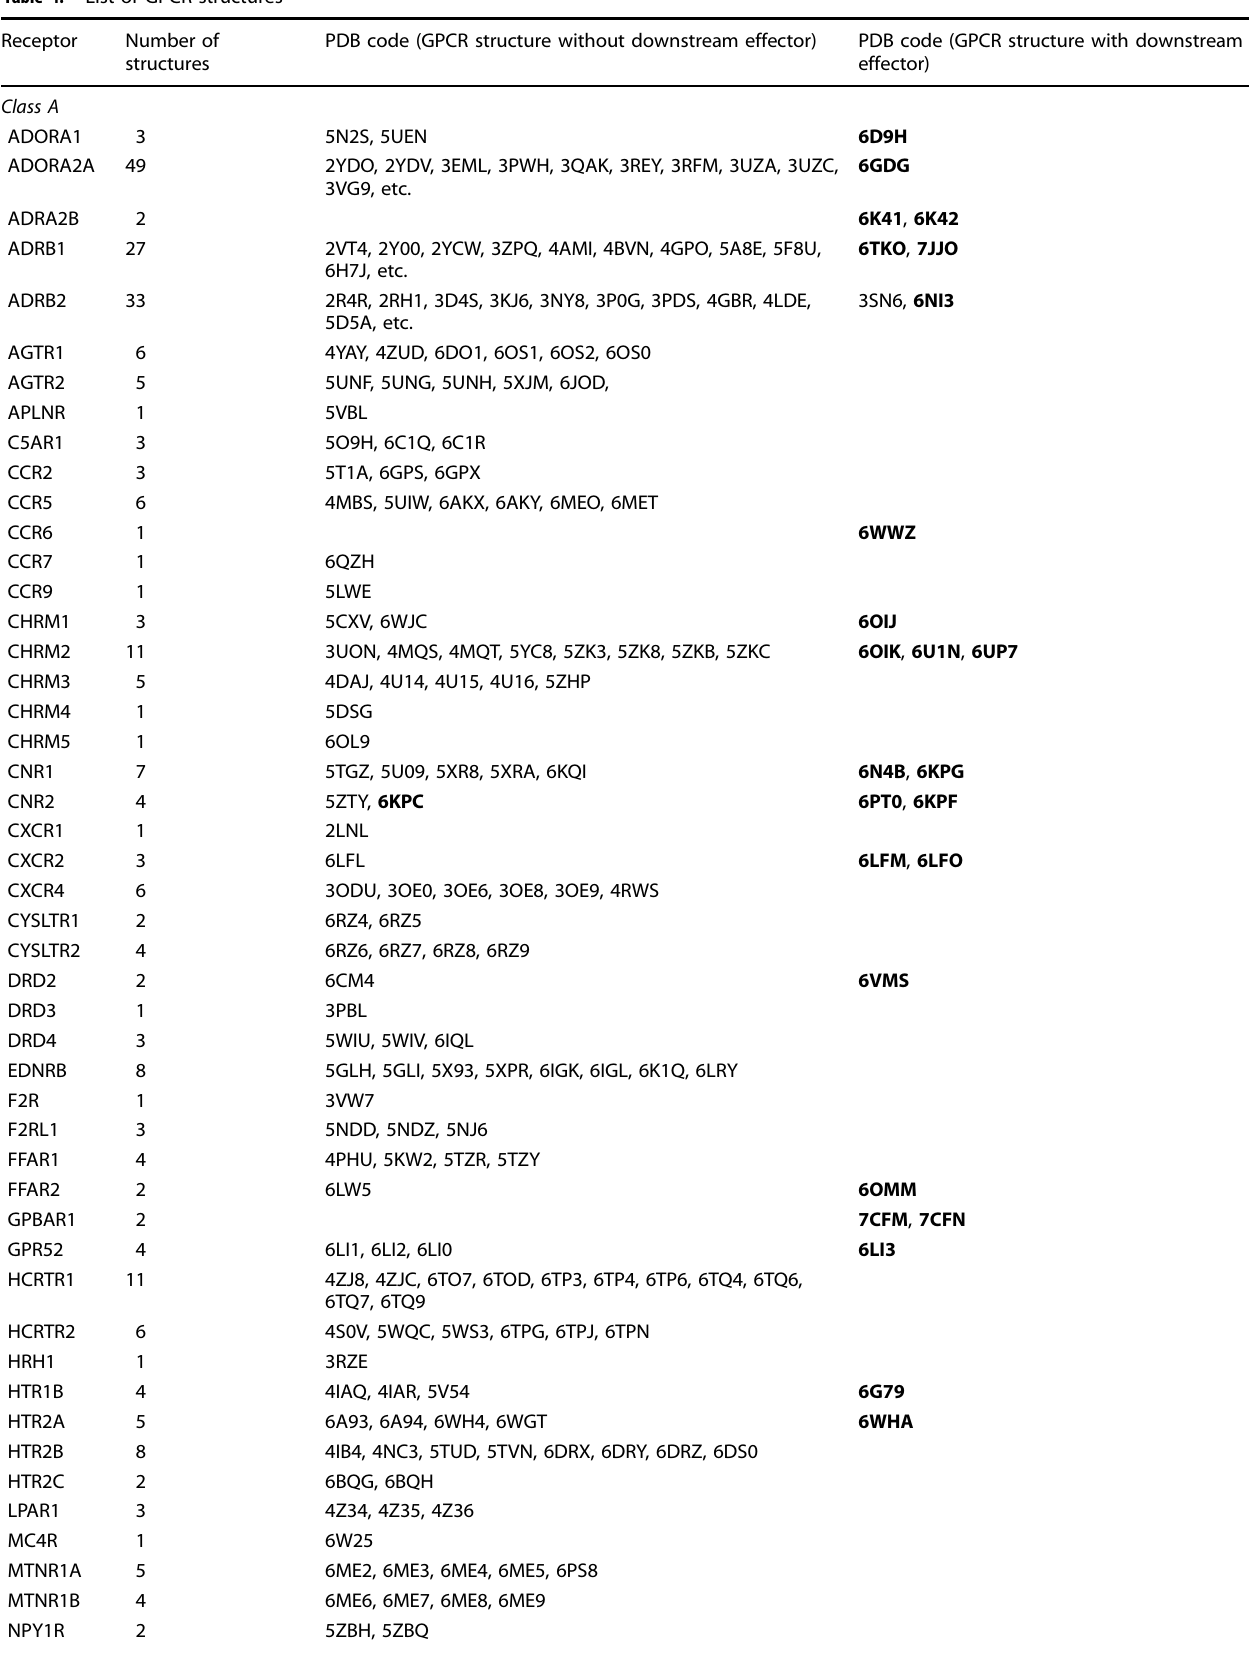
Table 4. List of GPCR structures Receptor Number of